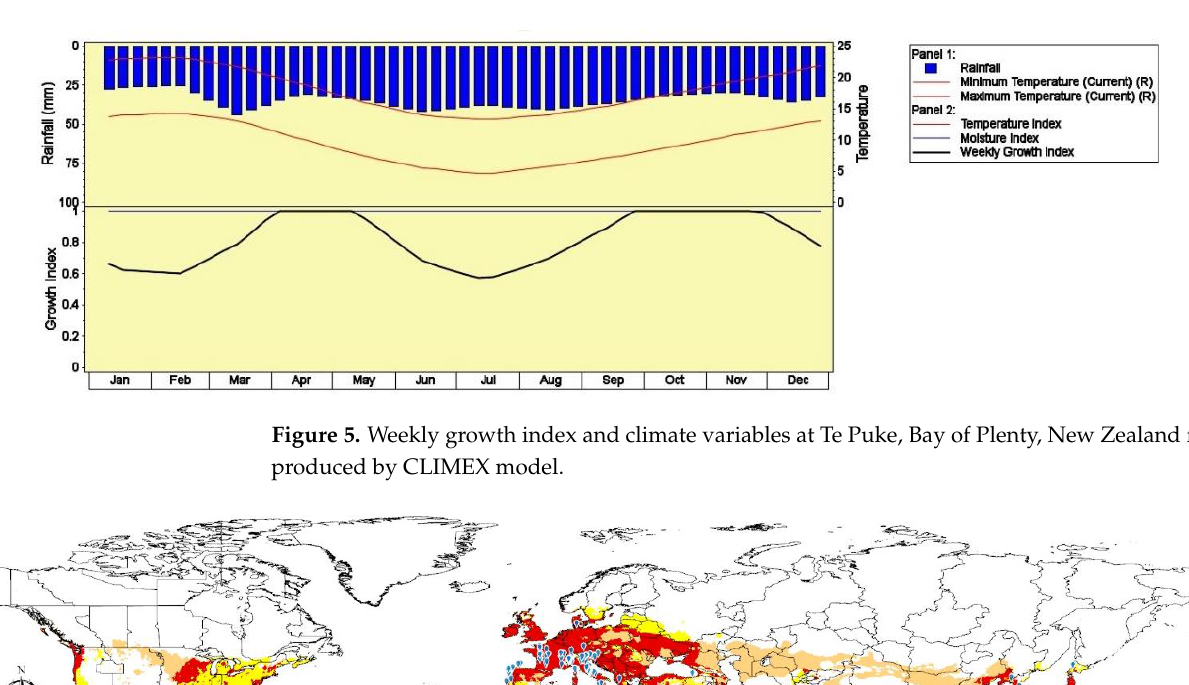
Figure 5. Weekly growth index and climate variables at Te Puke, Bay of Plenty, New Zealand for Psa produced by CLIMEX model.